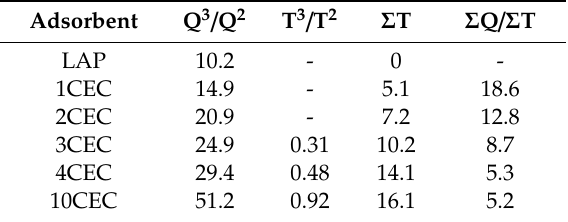
Table 1. Ratios obtained from the deconvolution of 29 Si NMR spectra.